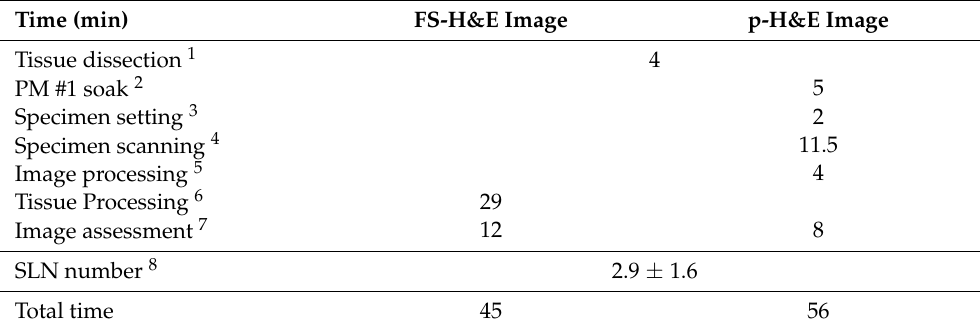
Table 2. The processing times for FS-H&E and p-H&E images.